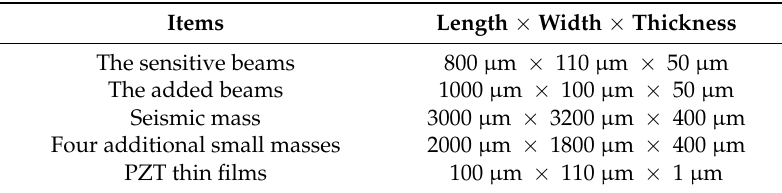
( b ) Figure 14. The schematic of the packaging and the photo of the packaged sensor. ( a ) The schematic of the packaging; ( b ) Photo of the packaged sensor. To test the performance of the piezoelectric output of the designed structure, a vibration test was carried out, as shown in Figure 15. The structure was on the vibration table, and different accelerations from 0 m/s 2 to 50 m/s 2 at 20 Hz were applied. In order to increase the output voltage, the two piezoelectric thin films were in series. The results are shown in Figure 16a. Obviously, the lines of the positive travel of measurement and the reverse travel of measurement match well; the structure kept the linearity satisfied. Based on Matlab, via calculation, the sensitivity of the piezoelectric acceleration was 0.00091 V/(m/s 2 ), the linearity was 0.0205 , and the hysteresis error was 0.0033. To measure the transverse motion of the accelerometer, we only needed to change the installation direction of the sensor. The results are shown in Figure 16b. The sensitivity of the X direction was 3.91343 × 10 (cid:2879)(cid:2873) V/(m/s 2 ), and the sensitivity of the Y direction was